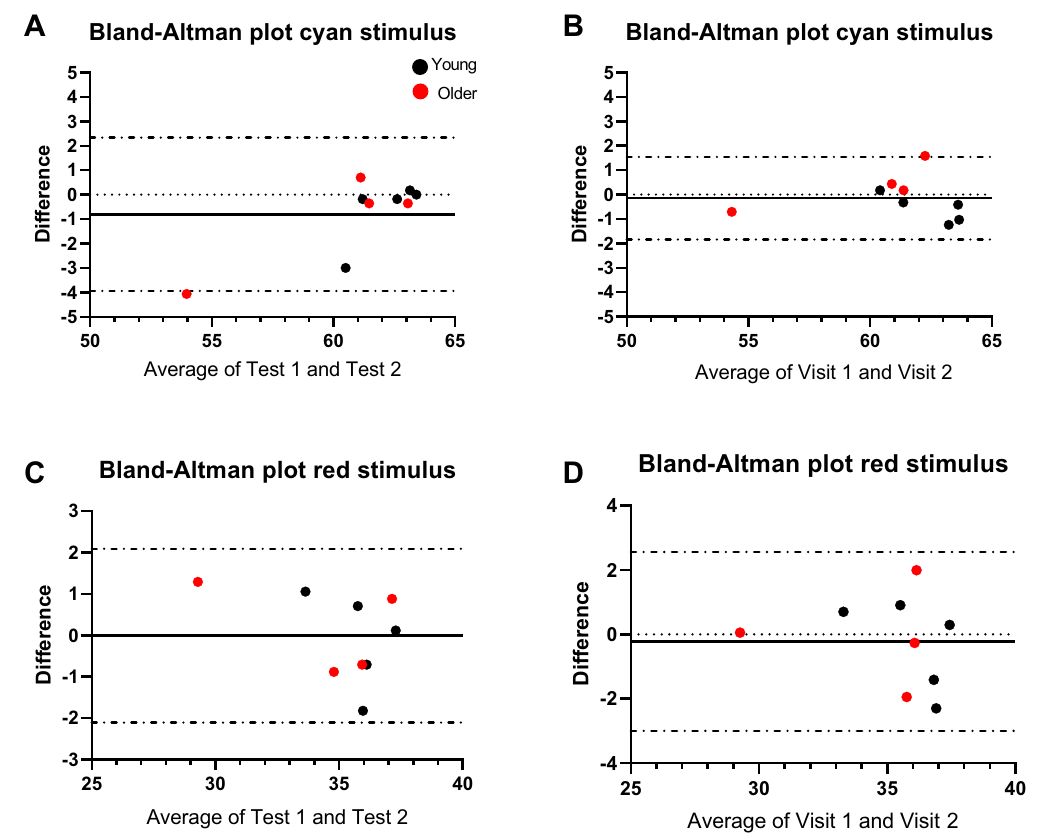
Figure 1. Bland–Altman plots with 95% limits of agreement (dashed lines) illustrate the difference in scotopic thresholds between intrasession measurements ( A ) cyan stimulus, ( C ) red stimulus, and between intersession measurements ( B ) cyan stimulus and ( D ) red stimulus. Black dotted line represents the mean between the two measurements. Black circles represent young participants (N = 5) and red circles represent older participants (N = 4).